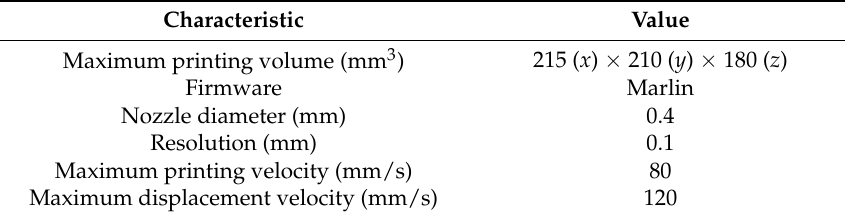
Table 2. The technical characteristics of the FDM equipment.